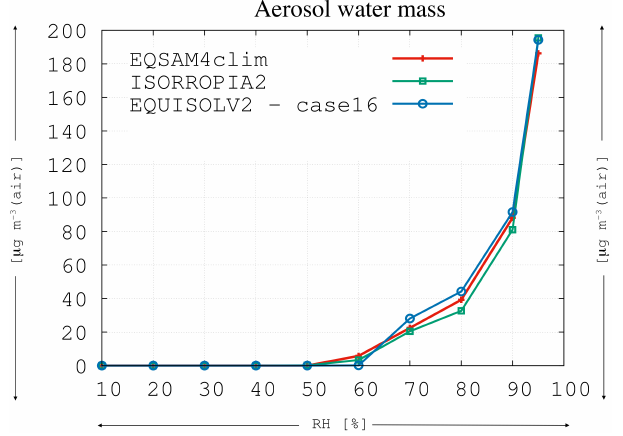
Figure 6. EQUISOLV II comparison – case 16. Bulk aerosol water mass as a function of RH for different sulfate molar ratios, fixed for the entire RH range (at constant T = 298 . 15K). The dry concen- = 2 . 0, tNO 3 = 1 . 0, tNaCl = 0 . 5, tration ratios of sulfate are tNH 4 tSO 4 tSO 4 tSO 4 tK = 0 . 04, tCa = 0 . 02, tMg = 0 . 01 and corresponds to domain tSO 4 tSO 4 tSO 4 1 of Table 2. This figure is extended to various (20 cases) sulfate molar ratios that are shown in Fig. S5 and correspond to Table 3 of Xu et al.